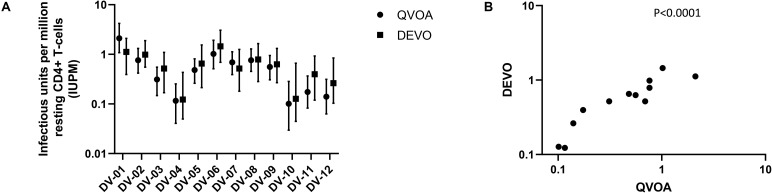
Comparison of IUPM values obtained in the DEVO assay at day 8 post-stimulation versus IUPM values obtained from the QVOA at day 15 post-stimulation. (A) The DEVO assay generated IUPM values that were either comparable or in some cases higher than values obtained with the traditional QVOA. However, overall, there was no significant difference in IUPM values between the two assays. P = 0.1294, Wilcoxon matched-pairs signed rank test. Twelve independent, paired assays from 12 distinct participants is shown. IUPM + 95% CI (upper and lower limits) is shown. (B) Correlation of the DEVO assay at day 8 post-stimulation with the QVOA at day 15 post-stimulation. Spearman r = 0.9282.